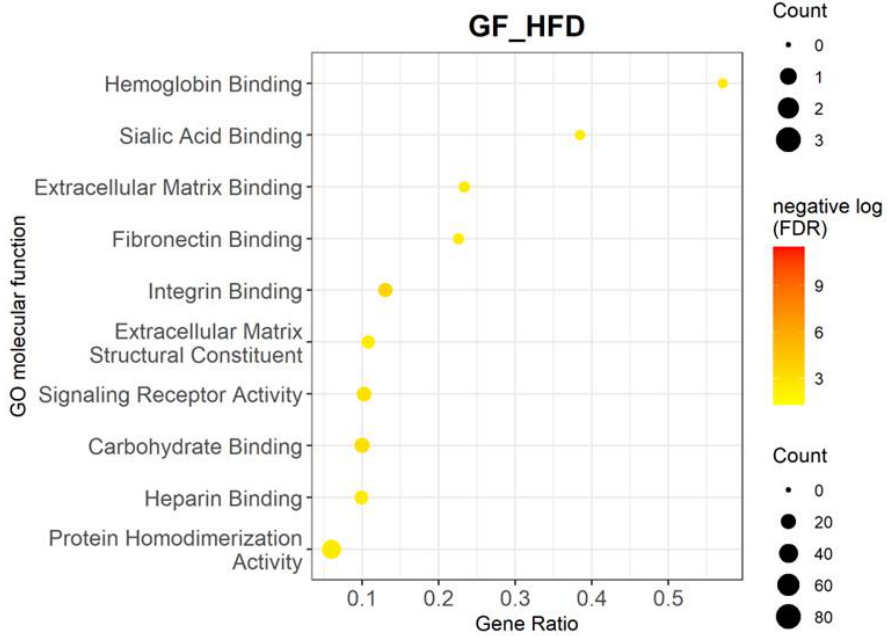
Figure 3. Enrichment analysis of DEGs between GF-HFD mice ( n = 4) and GF-ND mice ( n = 4) using Lynx. Gene ontology analysis is shown for top 10 molecular functions upregulated in GF-HFD mice compared to GF-ND mice. Functions such as extracellular matrix (ECM) binding, ECM structural